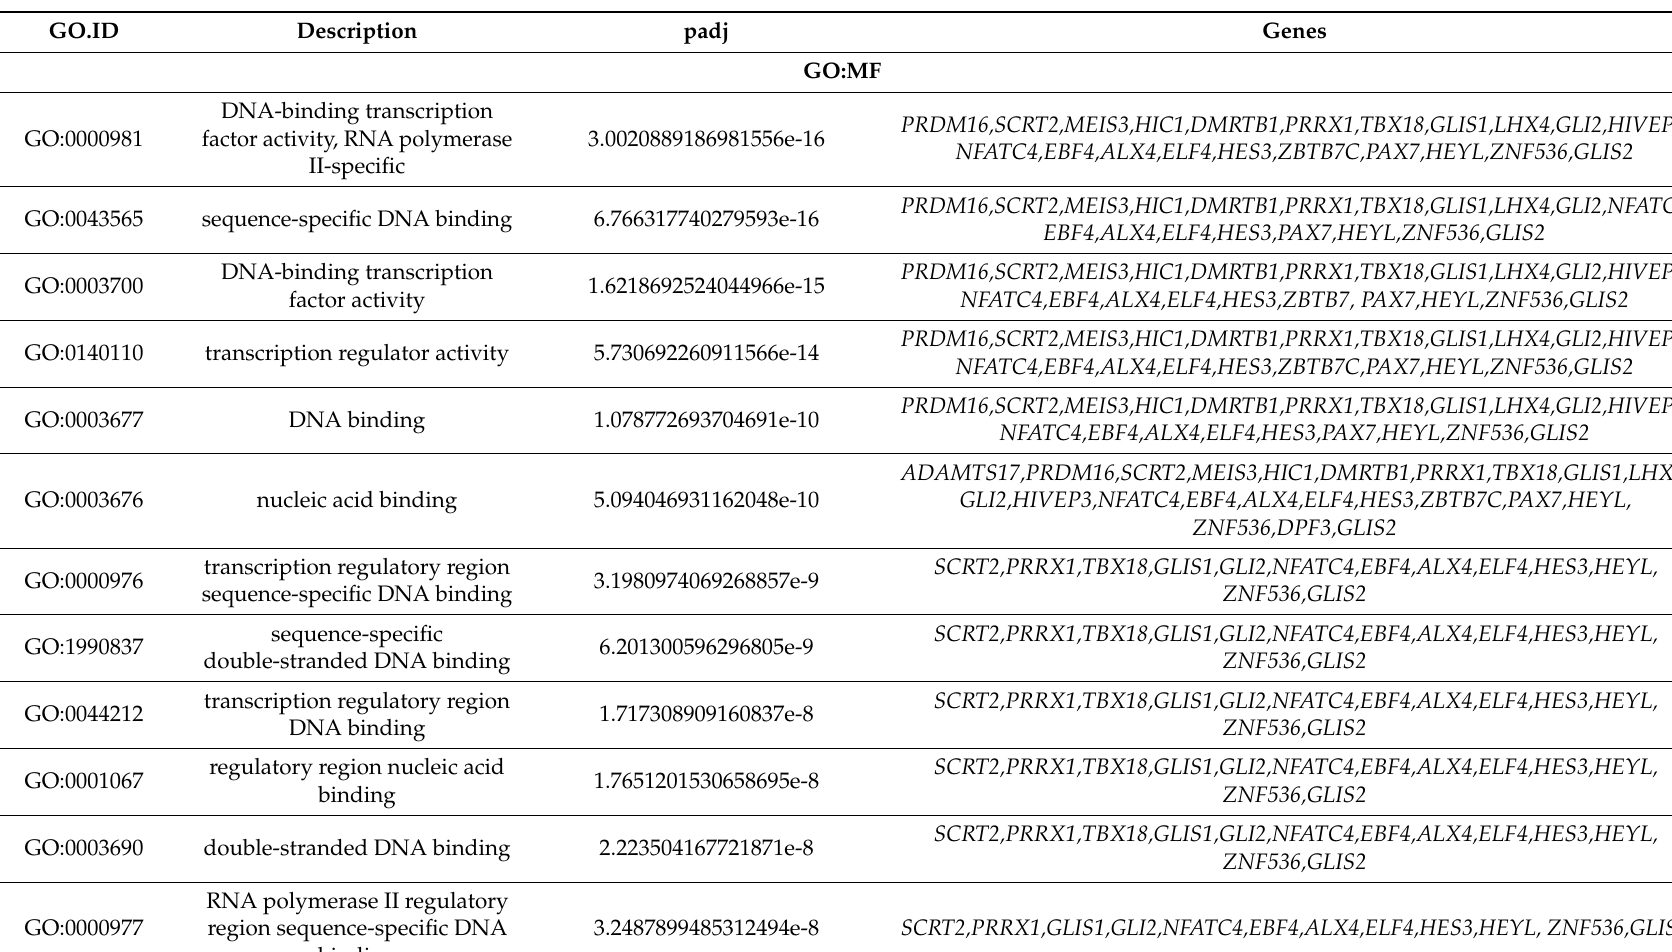
Table 1. Th GO associations of genes that are jointly regulated by 123 rDNA-contacting genes shown in Figure 5D. Top 22 results of a search in g:Profiler are shown. Complete results are shown in Table S21. The data are related to Figure 5D,E.